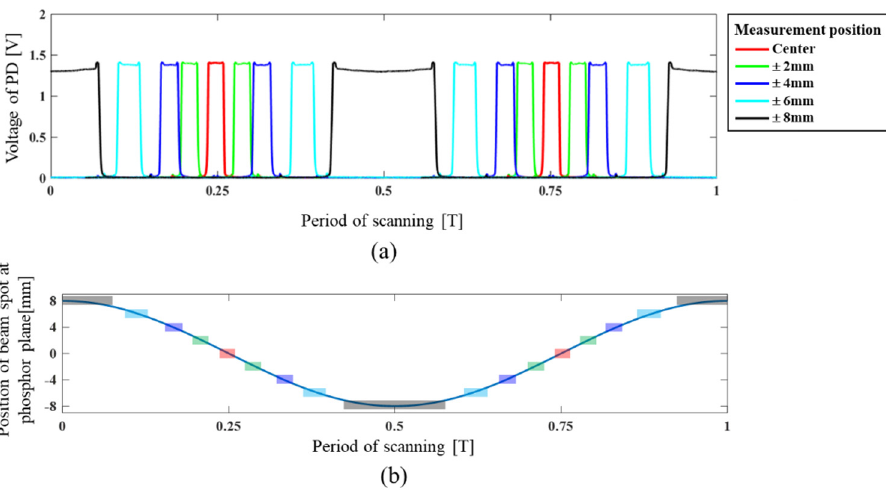
Figure 10. ( a ) Measured voltage by PD at phosphor plane in scanning system without prism. ( b ) Position of beam spot at phosphor plane according to scanning period in scanning system without prism.